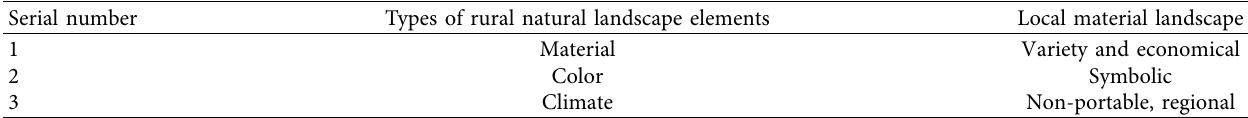
Table 4: Influencing factors of different rural landscapes.